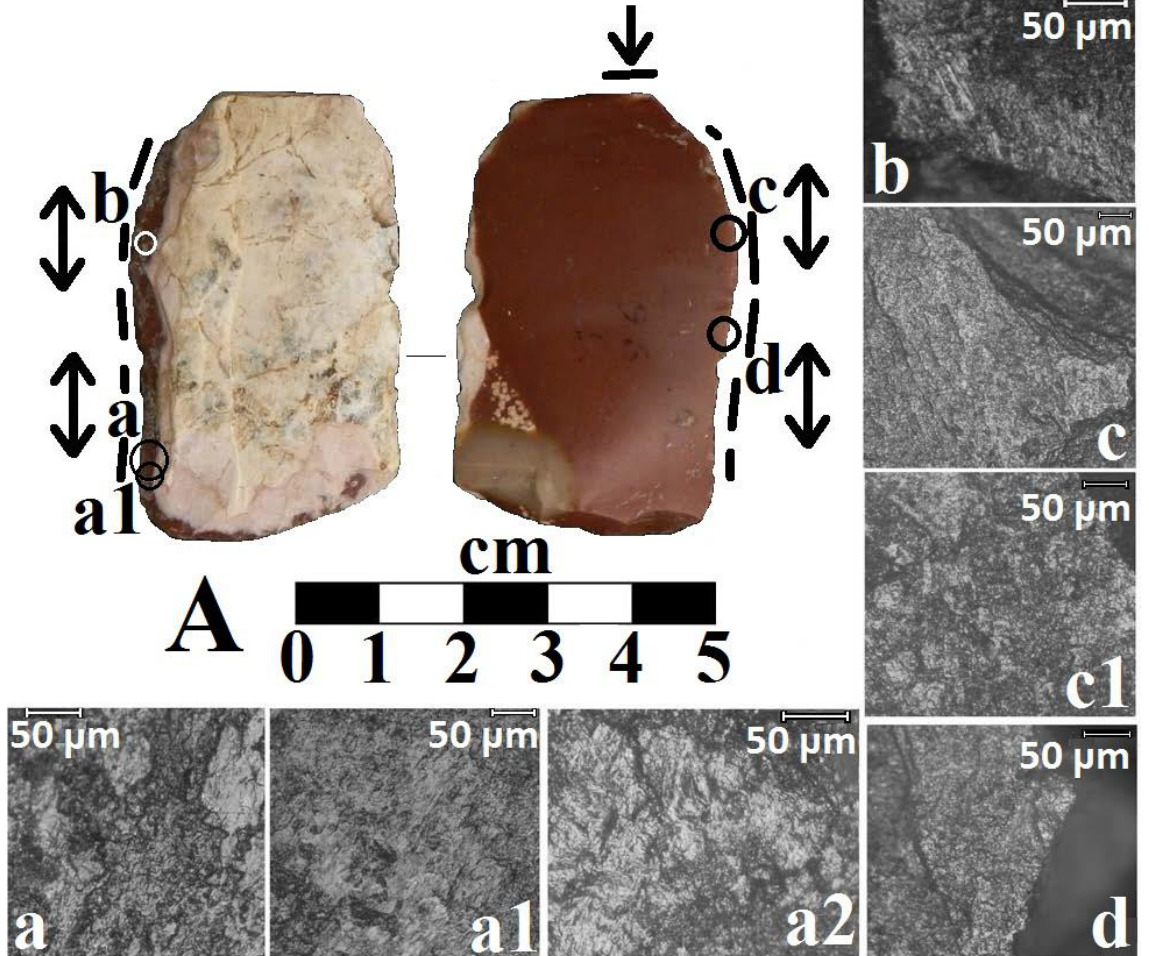
Figure 8. Late PN Heat-treated CFS fan scraper ( A ) from Ein Zippori used for skinning and butchering animals, possibly with thick fat layers, but without added abrasives. a , a1 : rough “greasy” and “feathered” meat or fresh hide microwear on A . a2 : Rough “greasy” polish on lustrous flint tool replica used to skin and butcher a deer. b , d : streaks of bright bone, striations, and rough hide or meat polish on A . c : rougher meat or fresh hide polish on A . c1 : meat or fresh hide polish on another edge of tool replica used to skin and butcher a deer. A : Dorsal (left) and ventral (right) faces of heat-treated oval CFS fan scraper (MW#12) Area C, late PN layer, Locus 1996, Bucket 90039. White lines: extent of usewear, arrows show orientation of polishes and striations, circles: locations of microphotographs a , a1 , b , c , d . All photomicrographs are 187.5x, all scales are 50